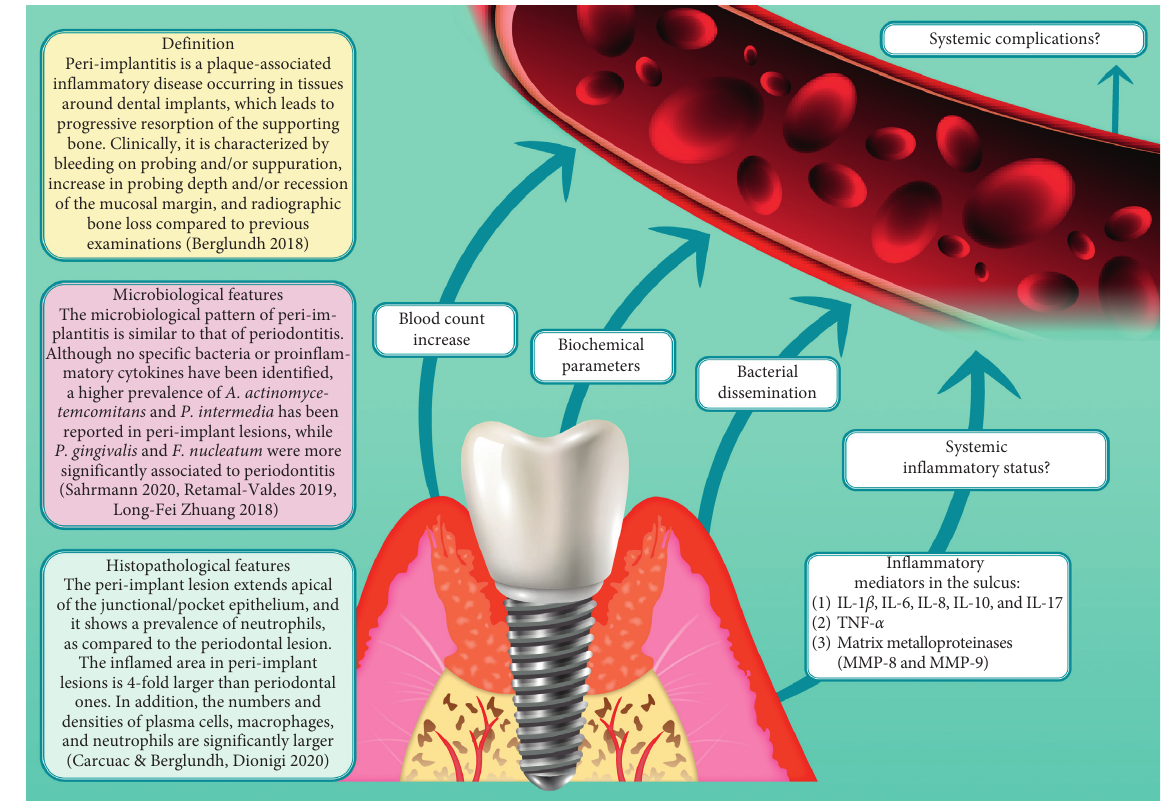
Figure 1: Different mechanisms of the potential impact of peri-implantitis on systemic